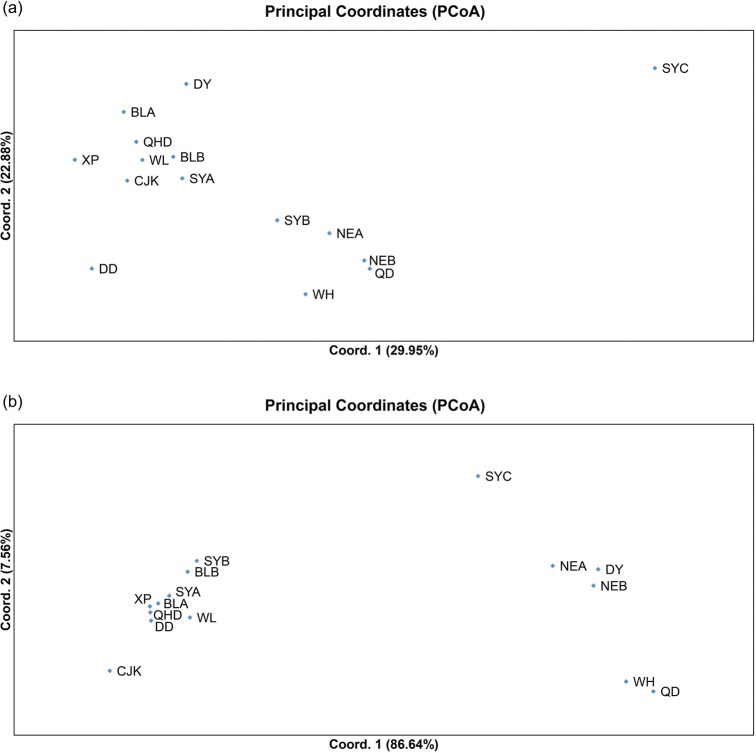
PCoA plotting of population differentiation based on (a) neutral microsatellites; (b) locus Lpol03.